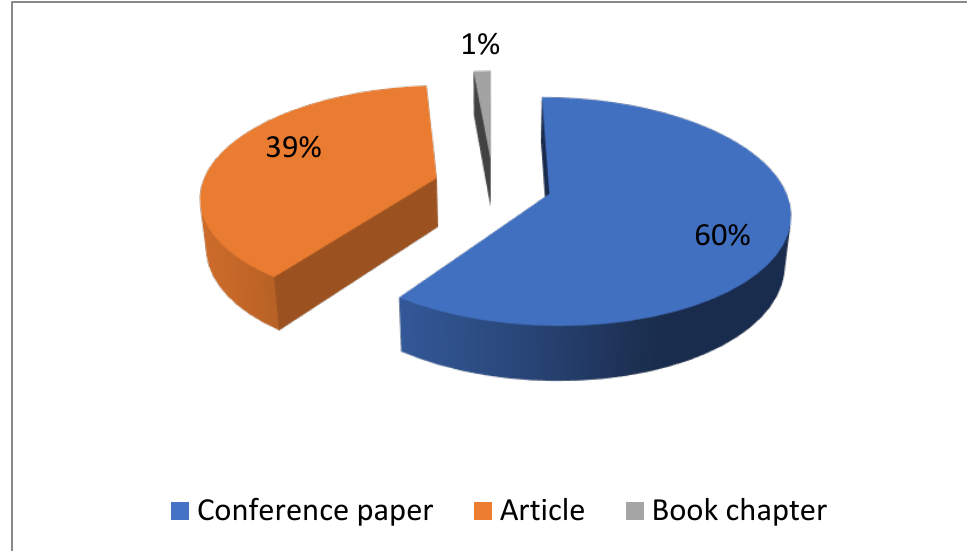
Figure 1. The pie chart illustrates the proportion of papers from different types of publications.